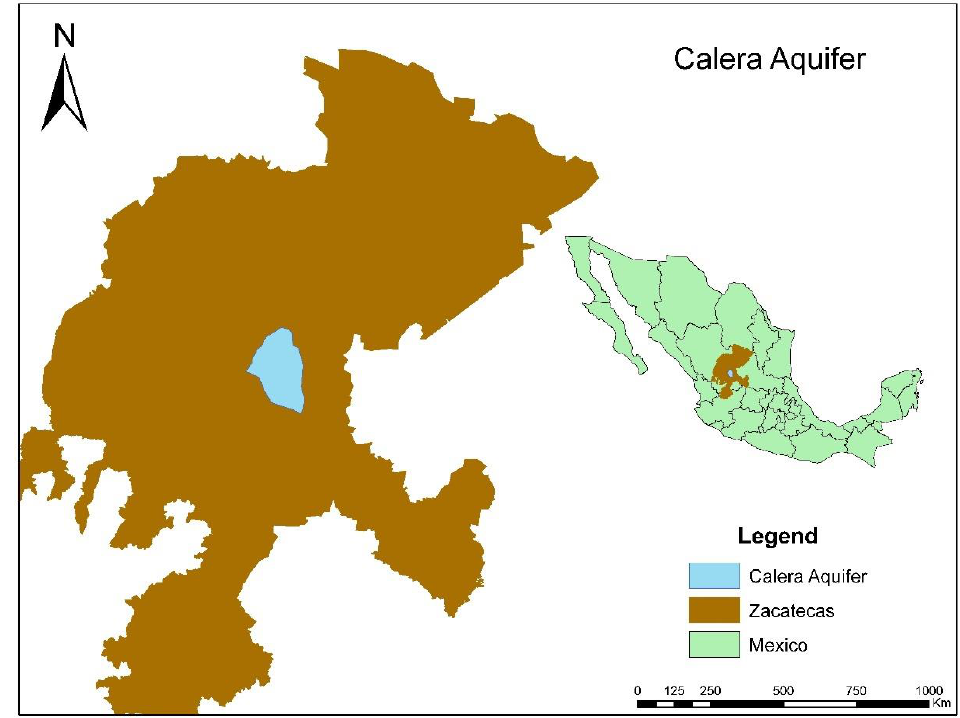
Figure 1. State of Zacatecas, Mexico, and location of the study area (Calera aquifer). According to the 2010 census in Mexico, within the Calera aquifer, there are 1417 wells, from which a total volume of 176.5 hm 3 of water is extracted annually. Of this, 159.2 hm 3 is used in the agricultural sector, 11.1 hm 3 for drinking water supply, 1.1 hm 3 for